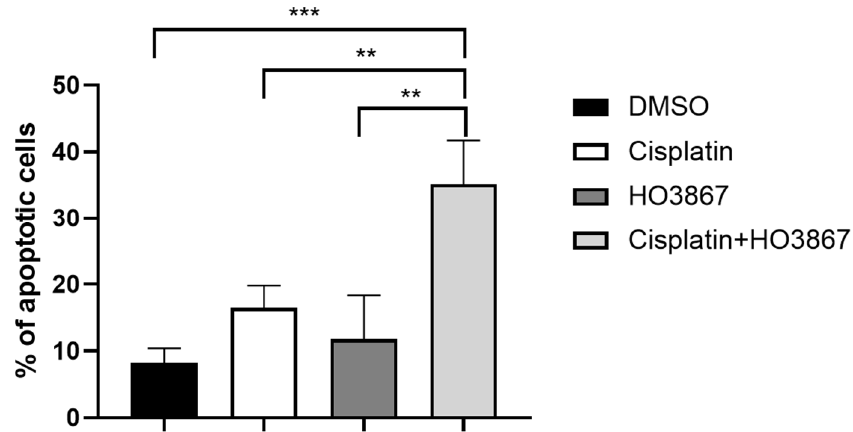
Figure 3. Combined treatment with cisplatin and STAT3 inhibitor enhances the apoptotic rate compared to cisplatin. Apoptotic cell death in KATO III gastric cancer cell lines exposed to 10 µ M of cisplatin or 10 µ M of HO3867 (STAT3 inhibitor) or the combination of both agents for 48 h. The data are expressed as the means ± SD. The significance was determined by one-way ANOVA followed by Dunnett’s multiple comparison tests. ** ( p < 0.01), *** ( p <